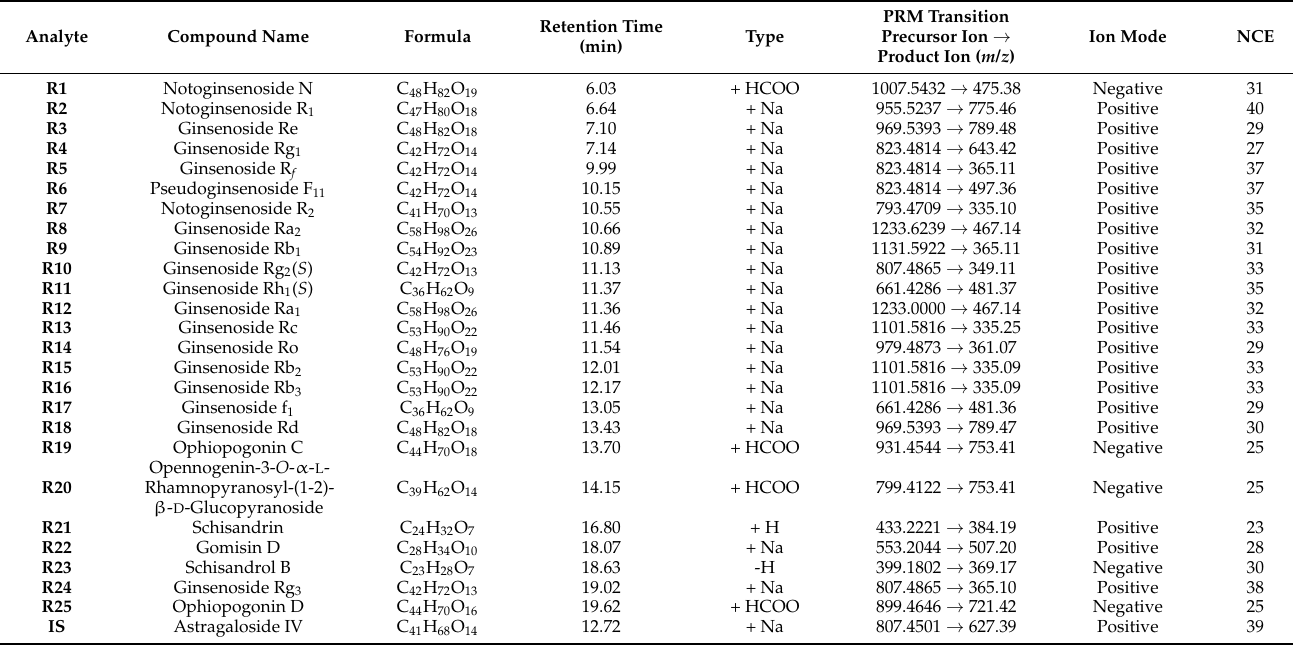
Table 1. Precursor/product ion pairs and PRM parameters of the 25 analytes used in this study.